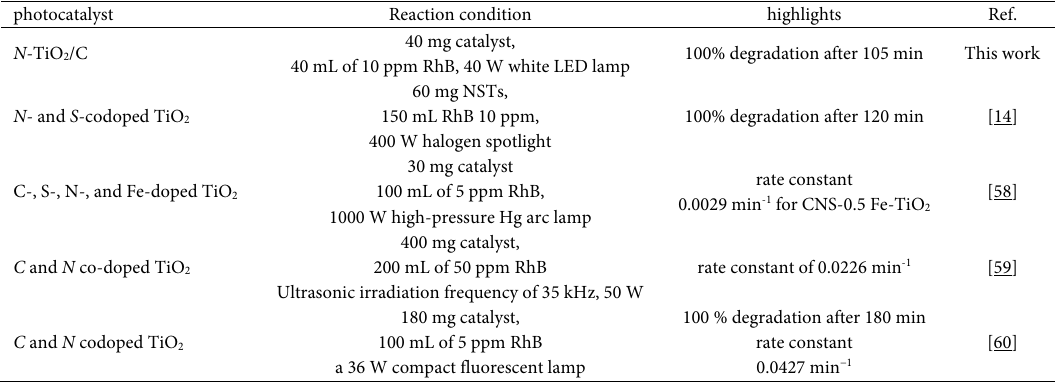
Table 2 Comparison of the catalytic activity of the N -TiO 2 /C with other documented doped TiO 2 catalysts in the degradation of RhB under visible light